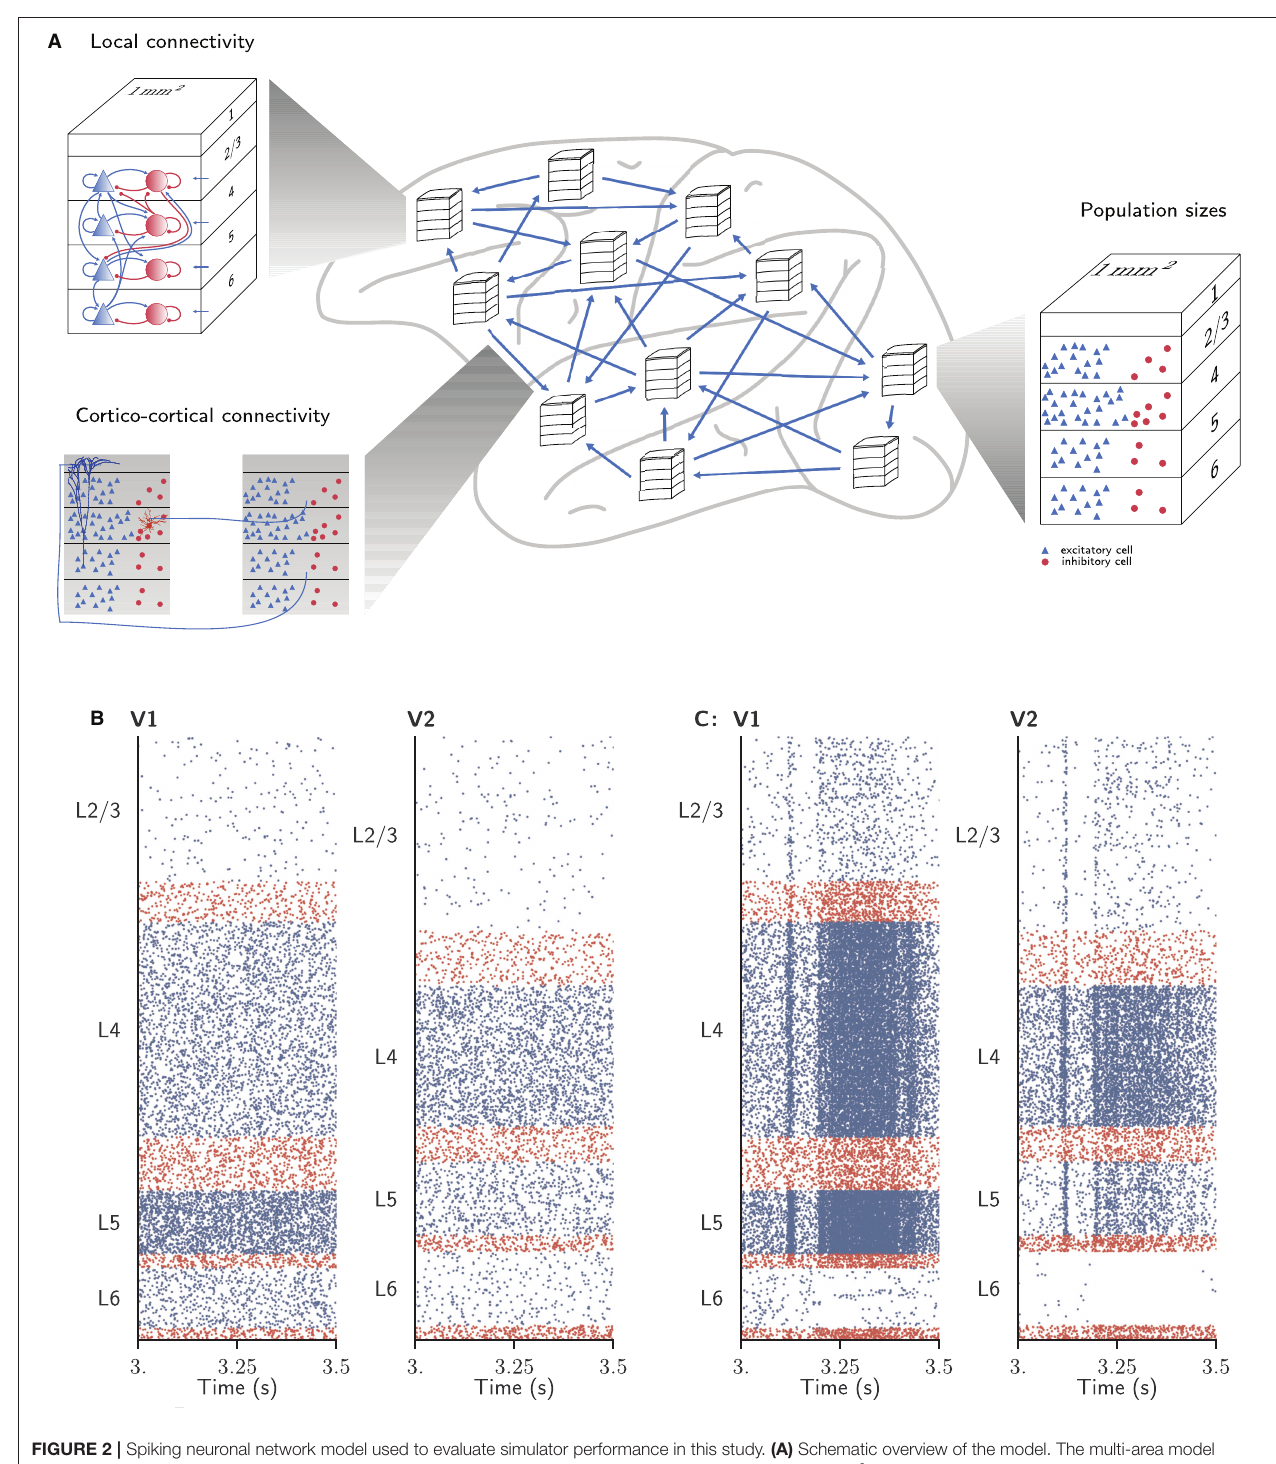
FIGURE 2 | Spiking neuronal network model used to evaluate simulator performance in this study. (A) Schematic overview of the model. The multi-area model represents 32 areas of macaque vision-related cortex, each modeled by four cortical layers with a size of 1mm 2 . Local connectivity, cortico-cortical connectivity, and population sizes are adapted for each area. (B) Network activity of areas V1 and V2 in the ground state. (C) Network activity of the same areas in the metastable state. Figure adapted from Schmidt et al. (2018a) and Schmidt et al. (2018b).